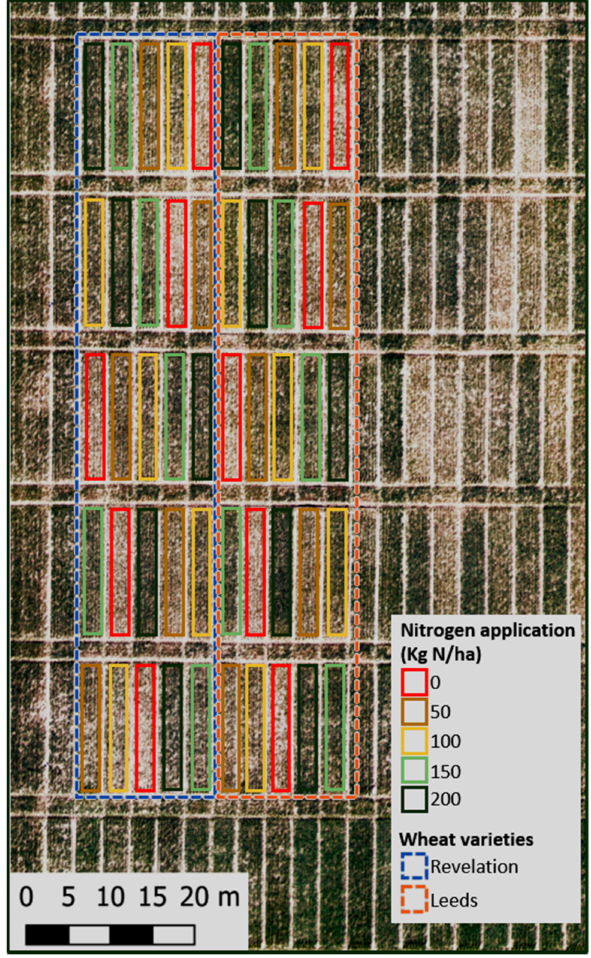
Figure 1. Design of the trials experiment in 2018, showing the replication of different fertilizer applications, and the use of two different wheat varieties. The image is an airborne mosaic of optical imagery from a drone-based camera, clearly showing the variation in crop state with treatment. The different fertilizer rates were chosen to artificially induce variation in yields up to the maximum standard for that soil type and area. For both years, the plots were sown at a seed rate of 340 m − 2 and were treated with a full fungicide and herbicide program along with 70 kg ha − 1 of P 2 O 5 and K 2 O. Harvest information was reported on a per plot basis at 15% moisture content and the yields in tons per hectare (t ha − 1 ) were calculated. 7 September (day of year 250). For the 2017/18 season, the sowing date was 30 September and harvest date was 25 August (day of year 237). Between the two growing seasons, the trial plot location was moved by ~1 km to an adjacent field to minimize the impact of any soil-remaining fertilizer on successive experiments. Both trial locations, however, were managed with the same crop rotation and had a Humbie soil series with a loam